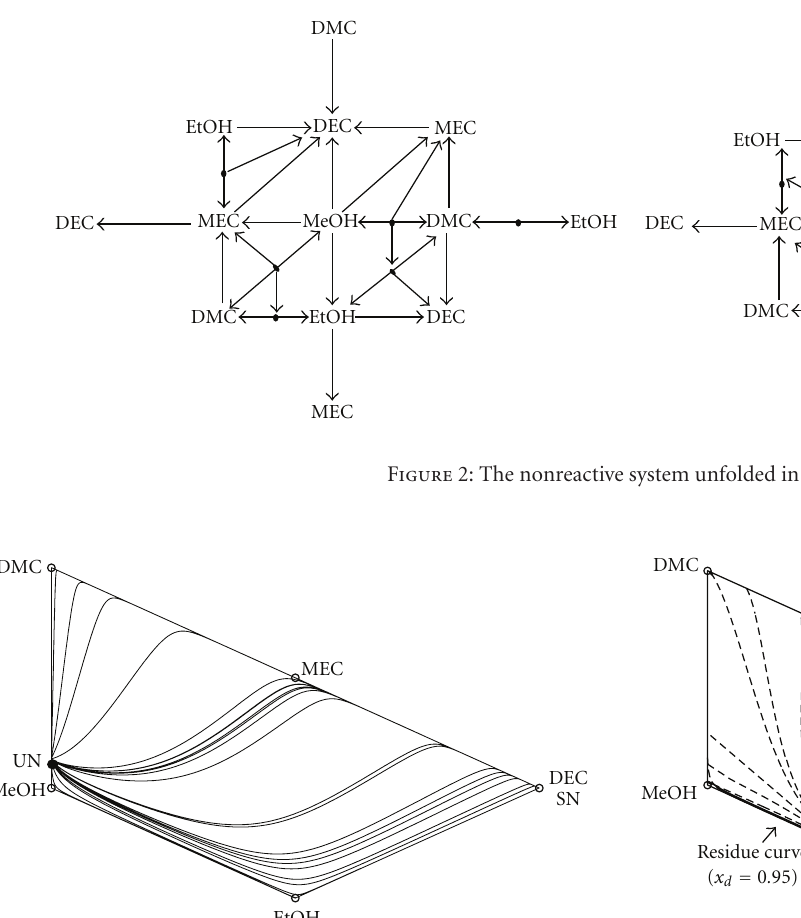
Figure 5: Reactive extractive profiles map at total reflux and feed ratio F/V = 0 .